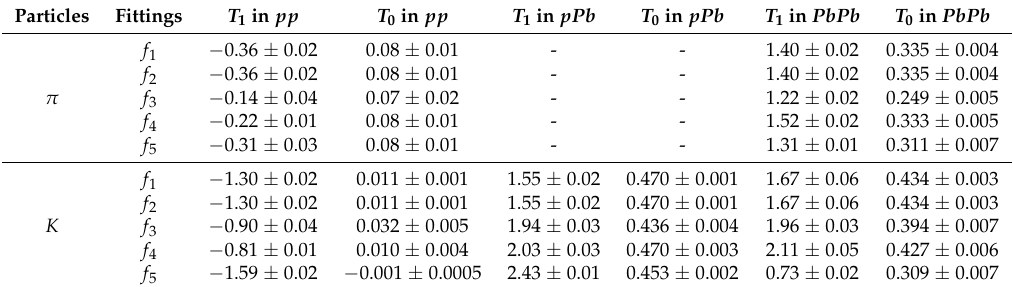
Table 5. Fitting parameters of Equation (11) between T and q − 1 = 1/ n for spectra of π (upper) and K (lower) in pp , pPb , and PbPb collisions (note that f BG is not included because q = 1 is a constant).